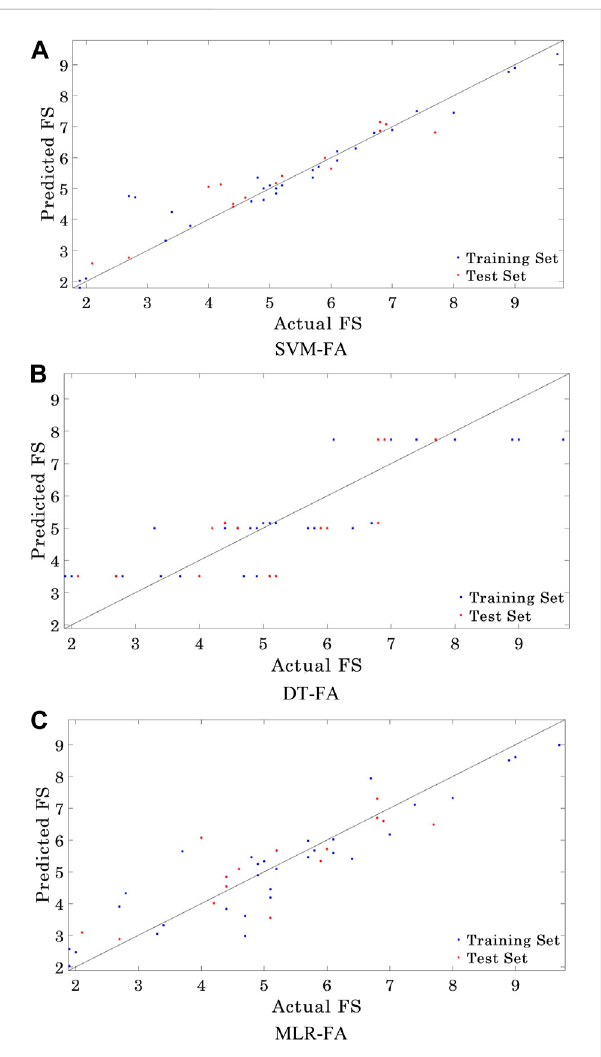
FIGURE 9 The fi tting effect of the predicted values and the actual values of the FS of recycled concrete by the machine learning models [ (A) : SVM-FA, (B) : DT-FA, (C) : MLR-FA].